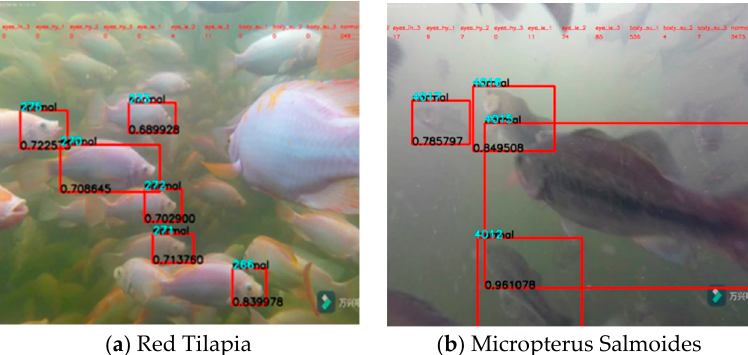
Figure 9. Monitoring effect of different varieties.